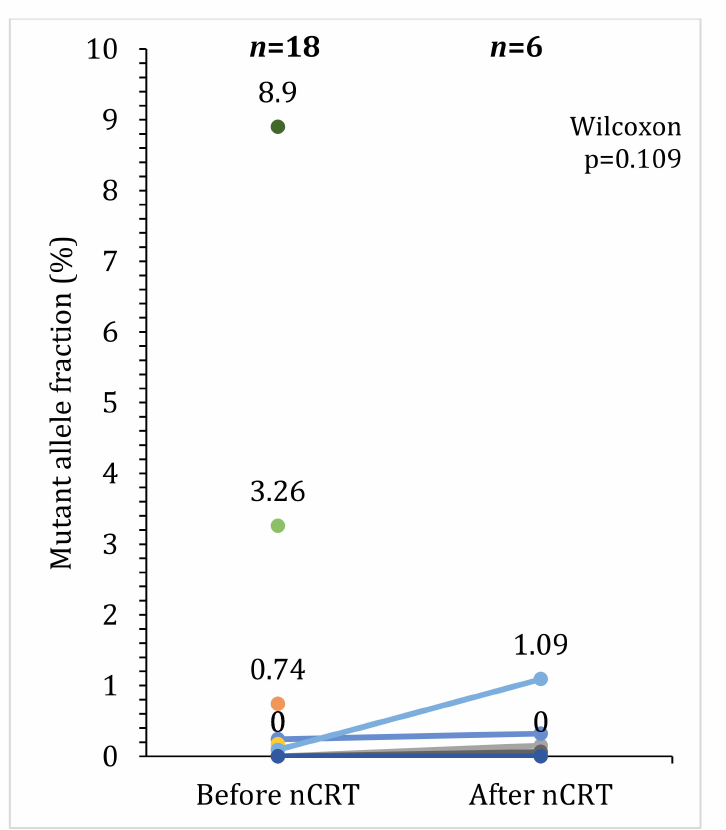
Figure 3. Mutant allele fractions in baseline and post-treatment samples and changes between the two